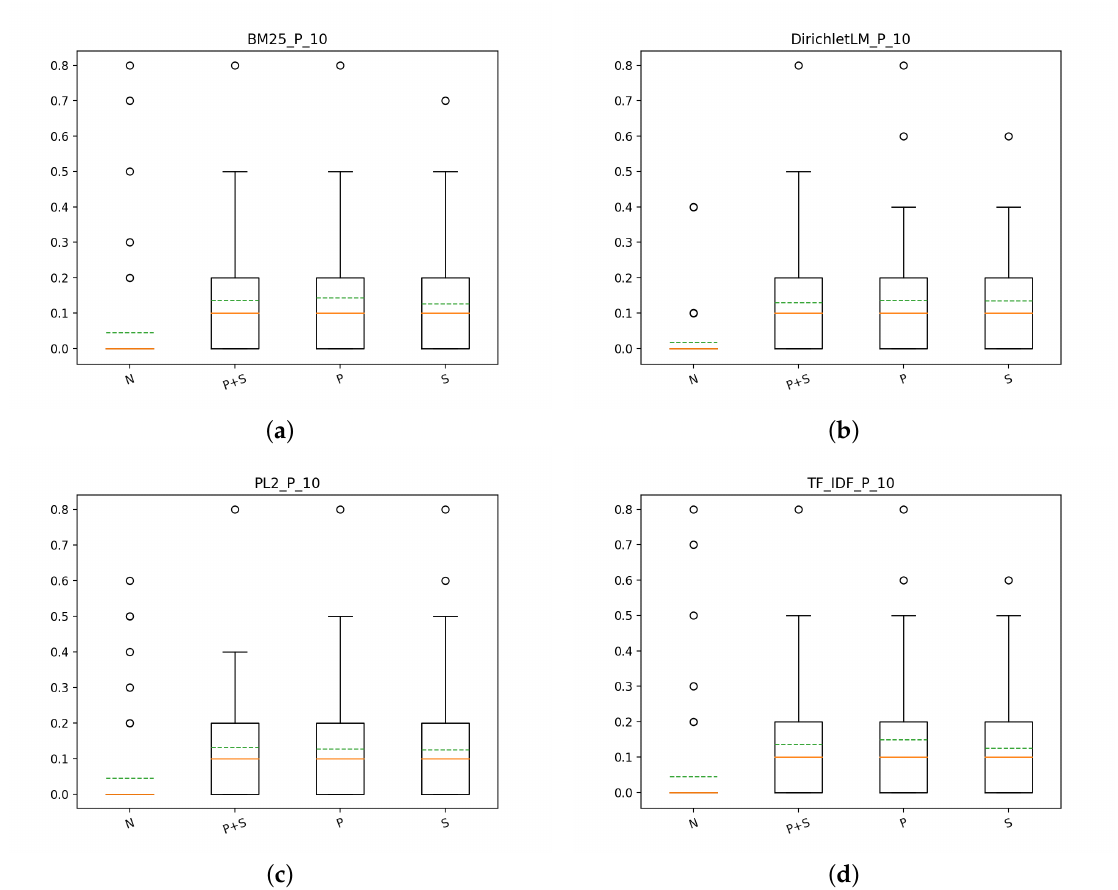
Figure 5. T1: box plots for P@10 of the different indexes for each model: ( a ) precision for BM25 with different indexes, ( b ) precision for DirichletLM with different indexes, ( c ) precision for PL2 with different indexes, ( d ) precision for TF-IDF with different